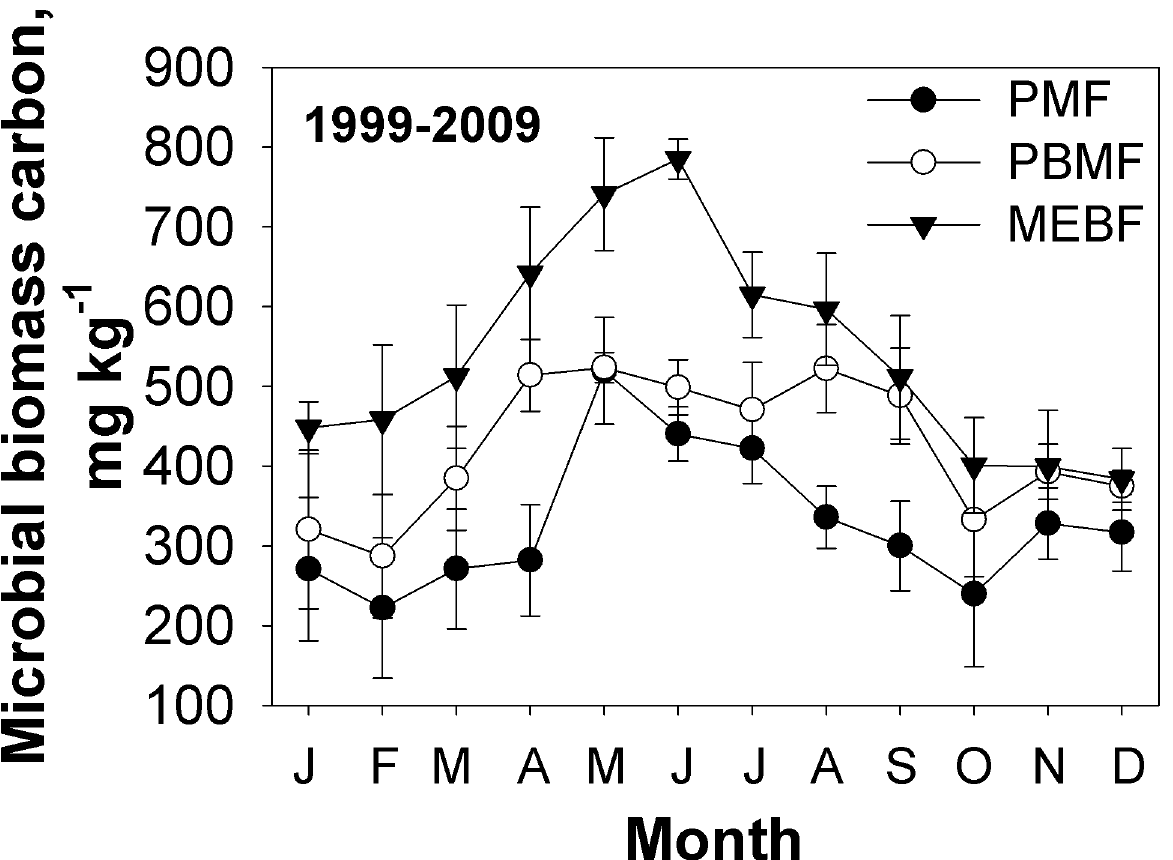
Figure 3. Mean monthly dynamics of soil microbial biomass carbon in the three forest types from 1999 to 2009.